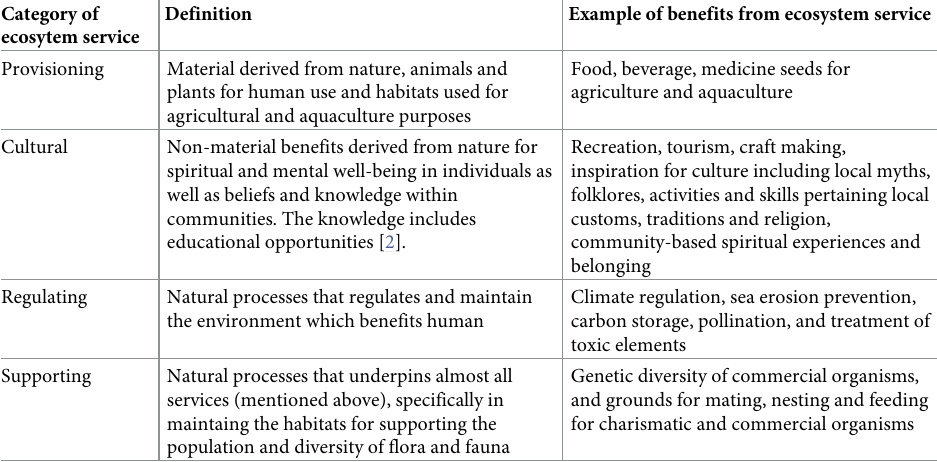
Table 1. Categories of ecosystem services used here that are related to the marine ecosystem in TMP. Categories, definitions and examples of the ecosystem services were introduced to participants before the start of activities to ensure they could provide information suitable for this study. The definitions and examples follow the glossary pro- vided by TEEB [3].